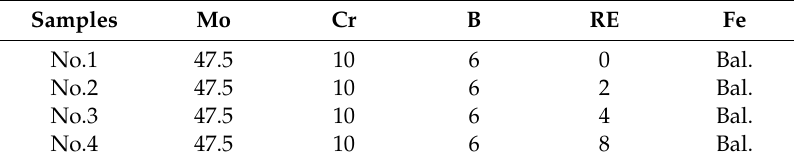
Table 2. Compositions of the alloy blocks